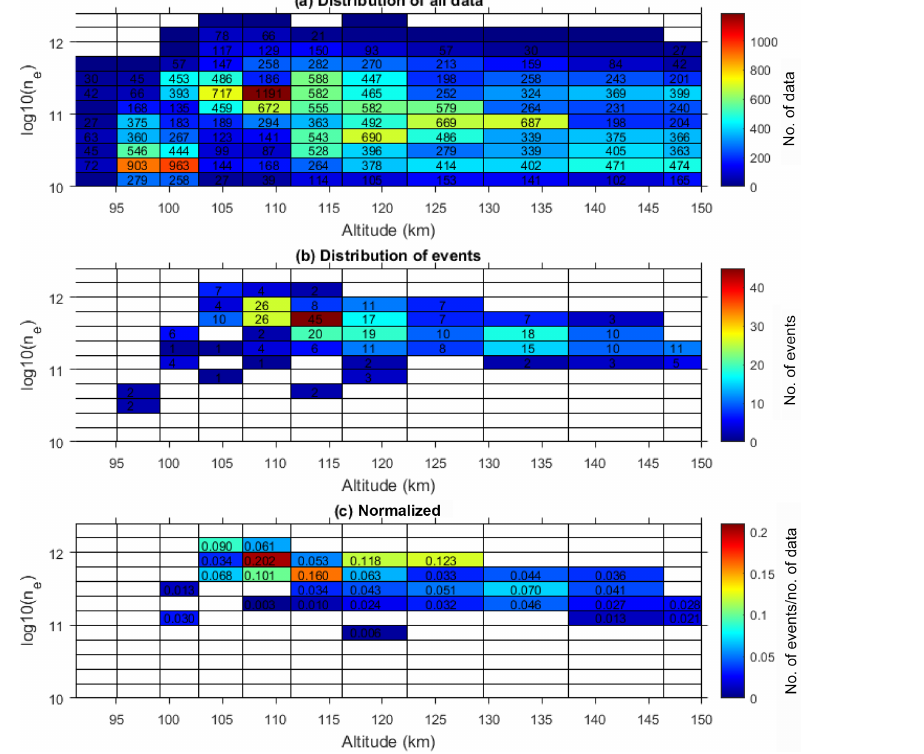
Figure 2. Distribution of E region peak altitude and peak electron density for (a) all investigated data and (b) events. In (c) the event distribution normalized by the data distribution is shown. The counts are also given in each